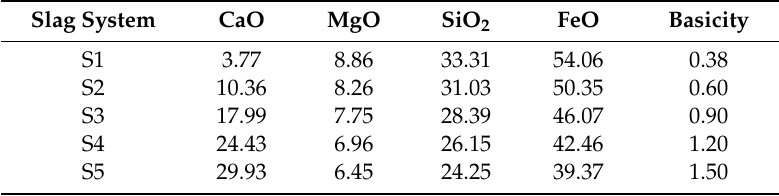
Table 1. Chemical composition of modified slag system (wt